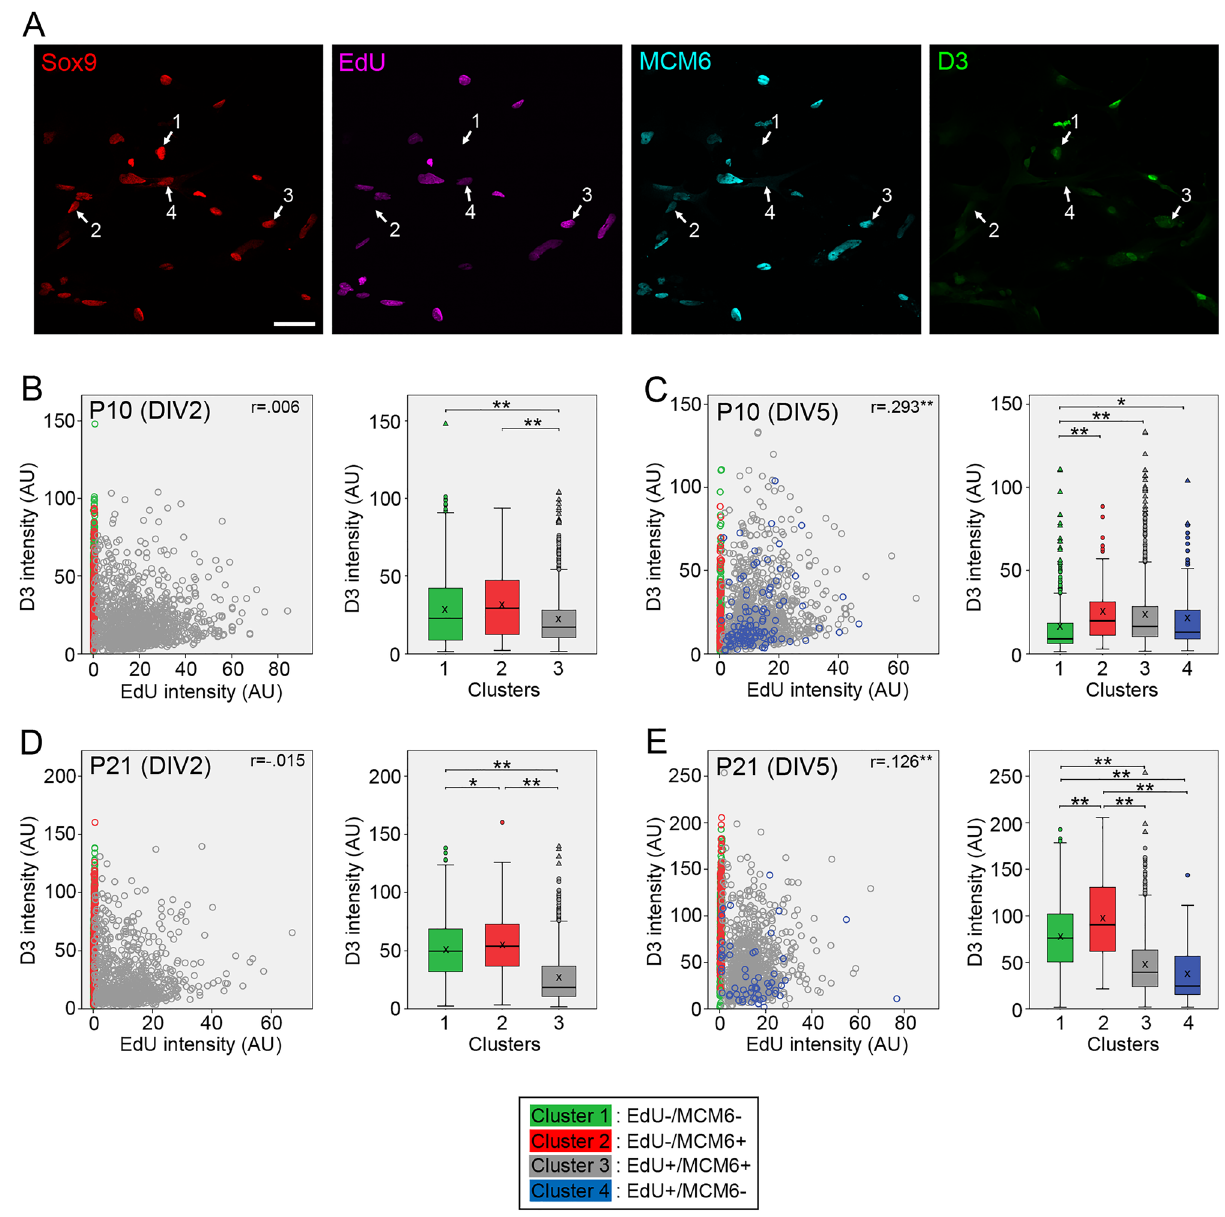
Figure 8. Quantitative analyses of cyclin D3 expression in Müller glia dissociated from P10 and P21 mouse retinas. Intensities of EdU, MCM6 and cyclin D3 labeling in Sox9 + Müller glia were quantitated by image analysis and cyclin D3 levels in Müller glia classified into four clusters are shown as scatter plots and box plots. ( A ) Confocal images of quadruple labeling for Sox9, EdU, MCM6 and cyclin D3 in Müller glia from P10 retina at DIV5. The numbers represent the clusters. Scale bar = 50 µm. ( B ) Plots of 2432 Müller glia from P10 retina at DIV2. ( C ) Plots of 1607 Müller glia from P10 retina at DIV5. ( D ) Plots of 1918 Müller glia from P21 retina at DIV2. ( E ) Plots of 1646 Müller glia from P21 retina at DIV5. AU arbitrary units. r , Spearman’s correlation coefficients between cyclin D3 and EdU intensities in the cluster 3. X in box plots indicates the mean. * P < 0.05, ** P <